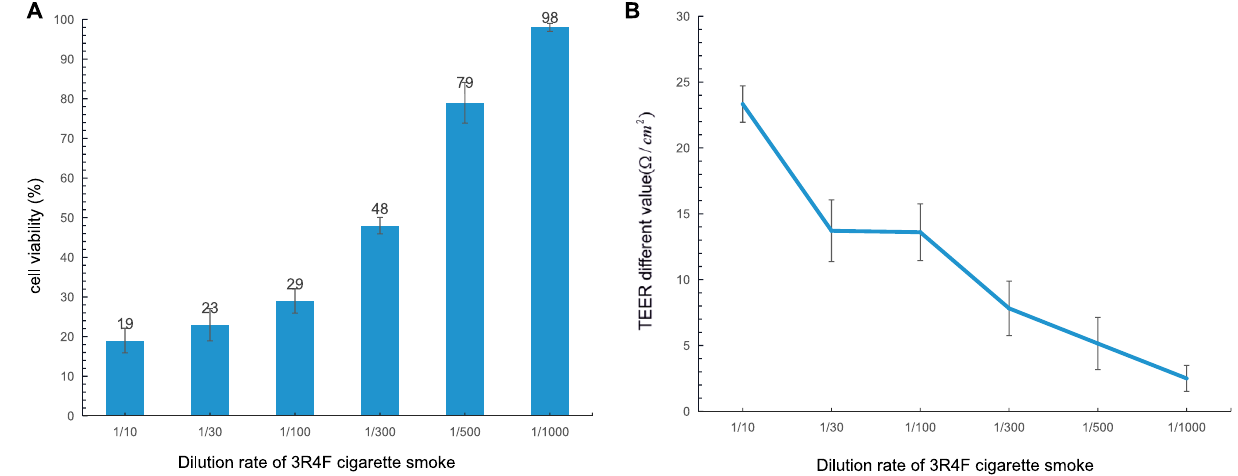
Figure 3. Different endpoints of assessing the effect of cigarette smoke dilution rates. A Cell viability as determined by neutral red uptake (NRU) assay under six different dilutions of 3R4F reference cigarette smoke. B Changes of TEER following treatment with different dilutions of 3R4F smoke. C. Boxplot of nicotine content in different kind of cigarette smoke under 500 times dilution. The mean value is shown by the horizontal line in the middle. **A t-test significance at p < 0.05 using the average nicotine content of other three cigarettes (3R4F, AB8, CB8) as